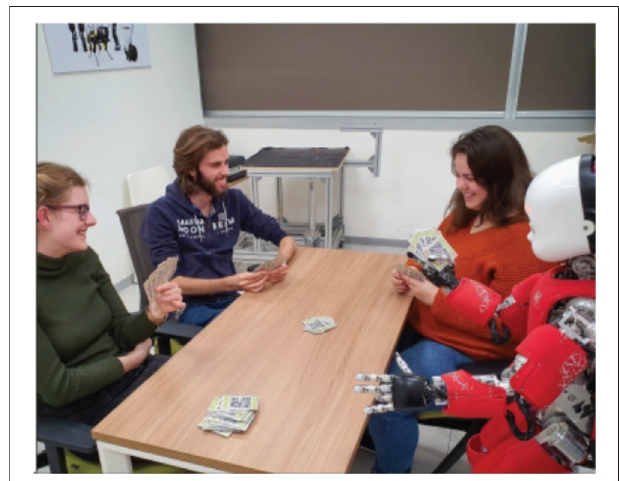
FIGURE 1 | Illustration of the Chef ’ s Hat card game being played by three humans and a